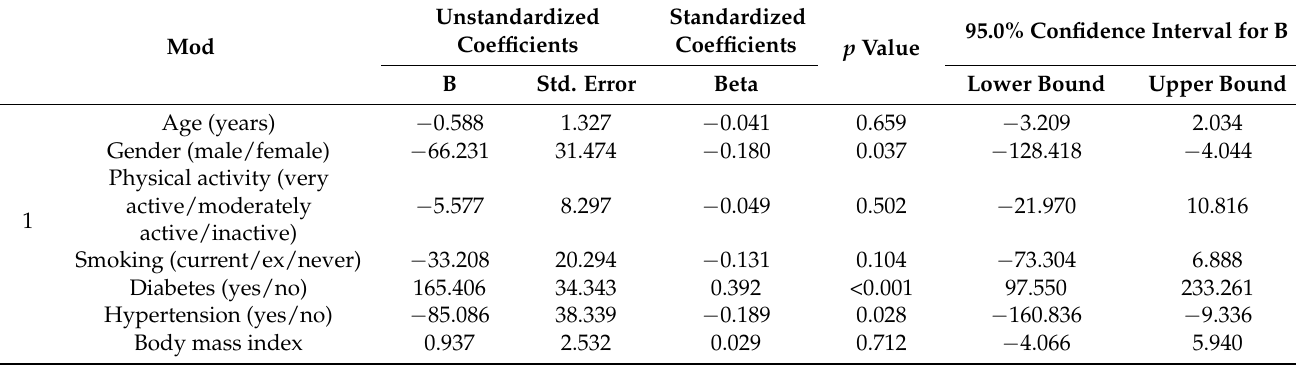
Table 6. Multiple regression results of age, gender, physical activity, BMI, history of smoking, diabetes, and high blood pressure on